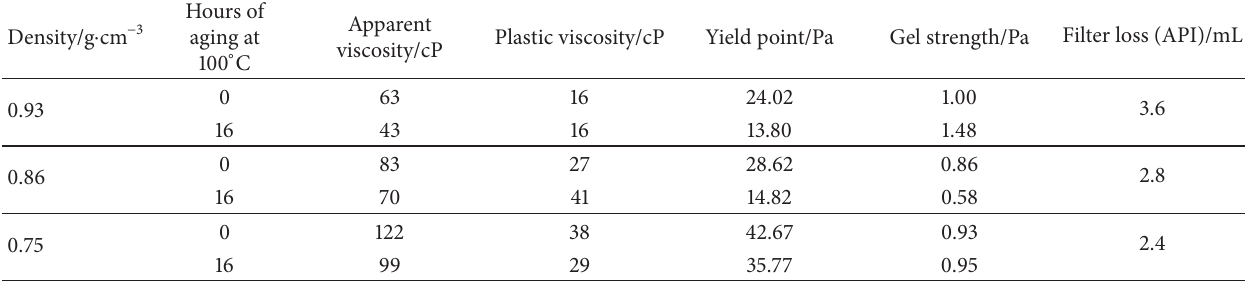
Table 2: Basic performance test of drilling fluid.